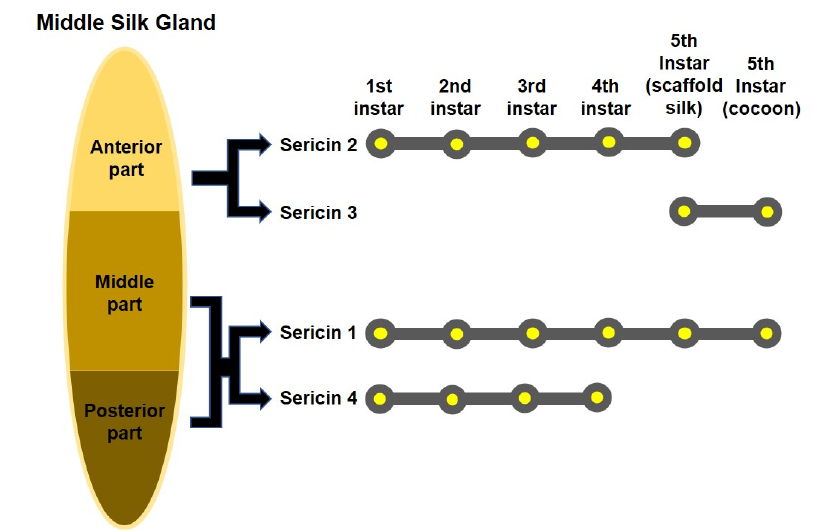
Figure 1. The middle silk gland of the silkworm and sericin gene expression.